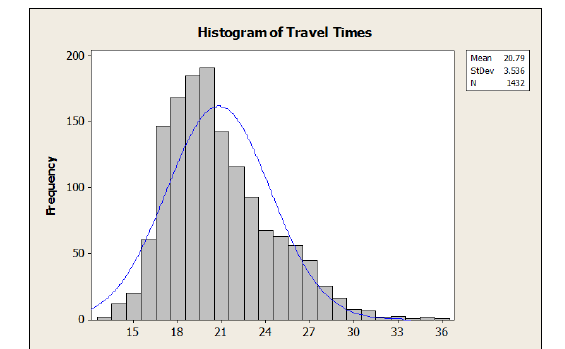
Fig. 7. Histogram for the travels times dataset of the route starting from station EKP of the BRT line 34 to the interchange station of line